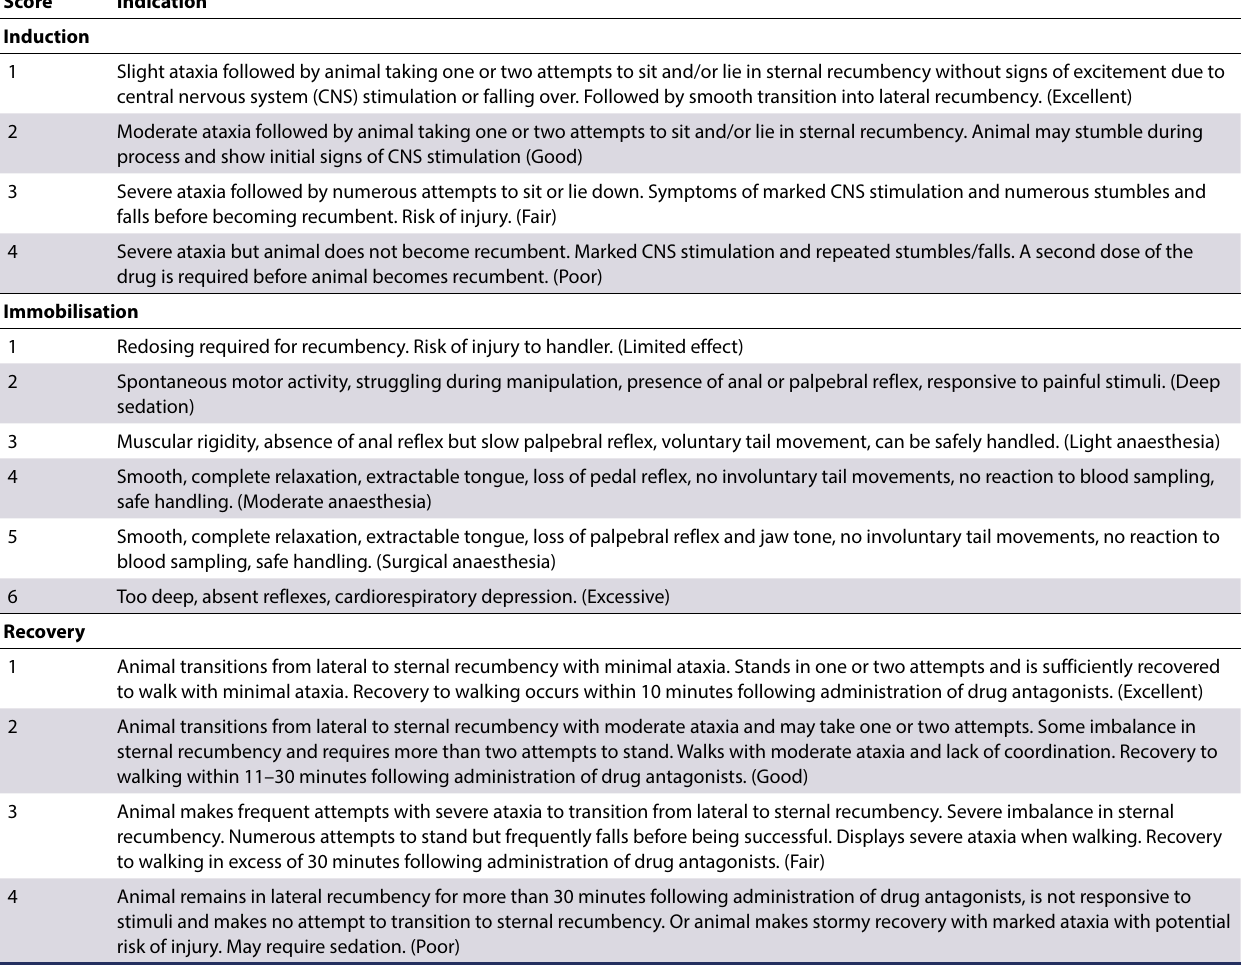
Table I: Description of the scoring system used to categorise the quality of the induction, immobilisation and recovery of free-ranging African lions ( Panthera leo ) immobilised with tiletamine-zolazepam-medetomidine, ketamine-medetomidine or ketamine-butorphanol-medetomidine (Wenger et al.